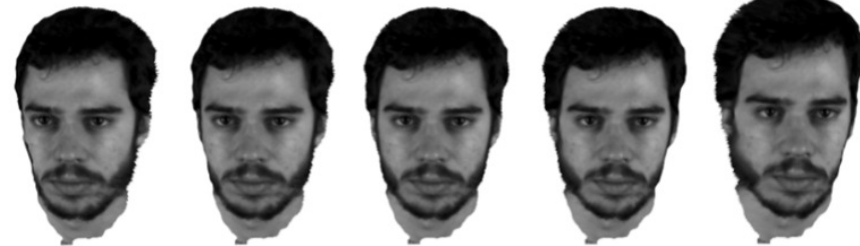
Figure 21. Example head views generated for printing.